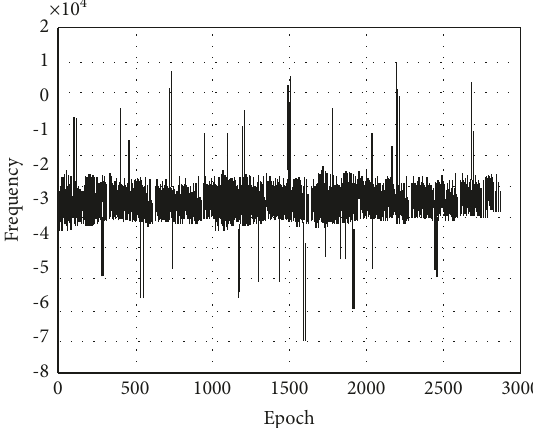
Figure 2: PRN10 satellite frequency